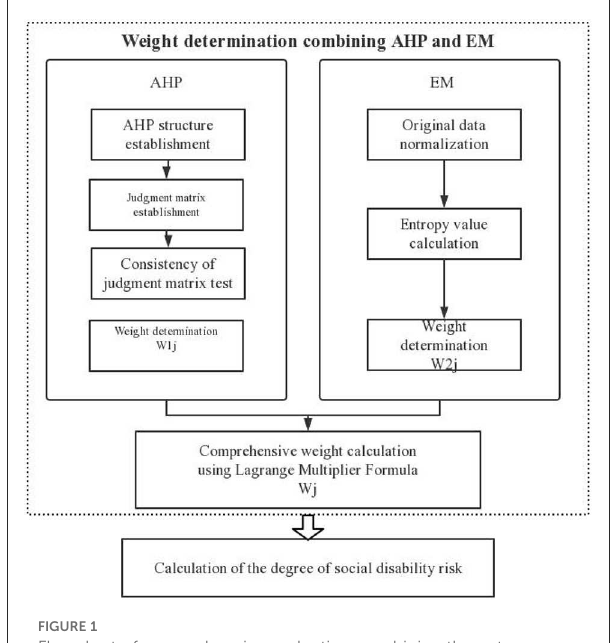
FIGURE1 Flowchart of comprehensive evaluation combining the entropy method (EM) and analytic hierarchy process